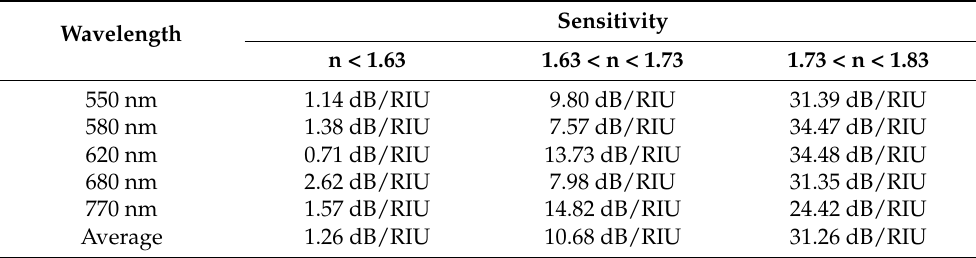
Table 3. The dependence of our device’s sensitivity on the refractive index of the material to be detected.